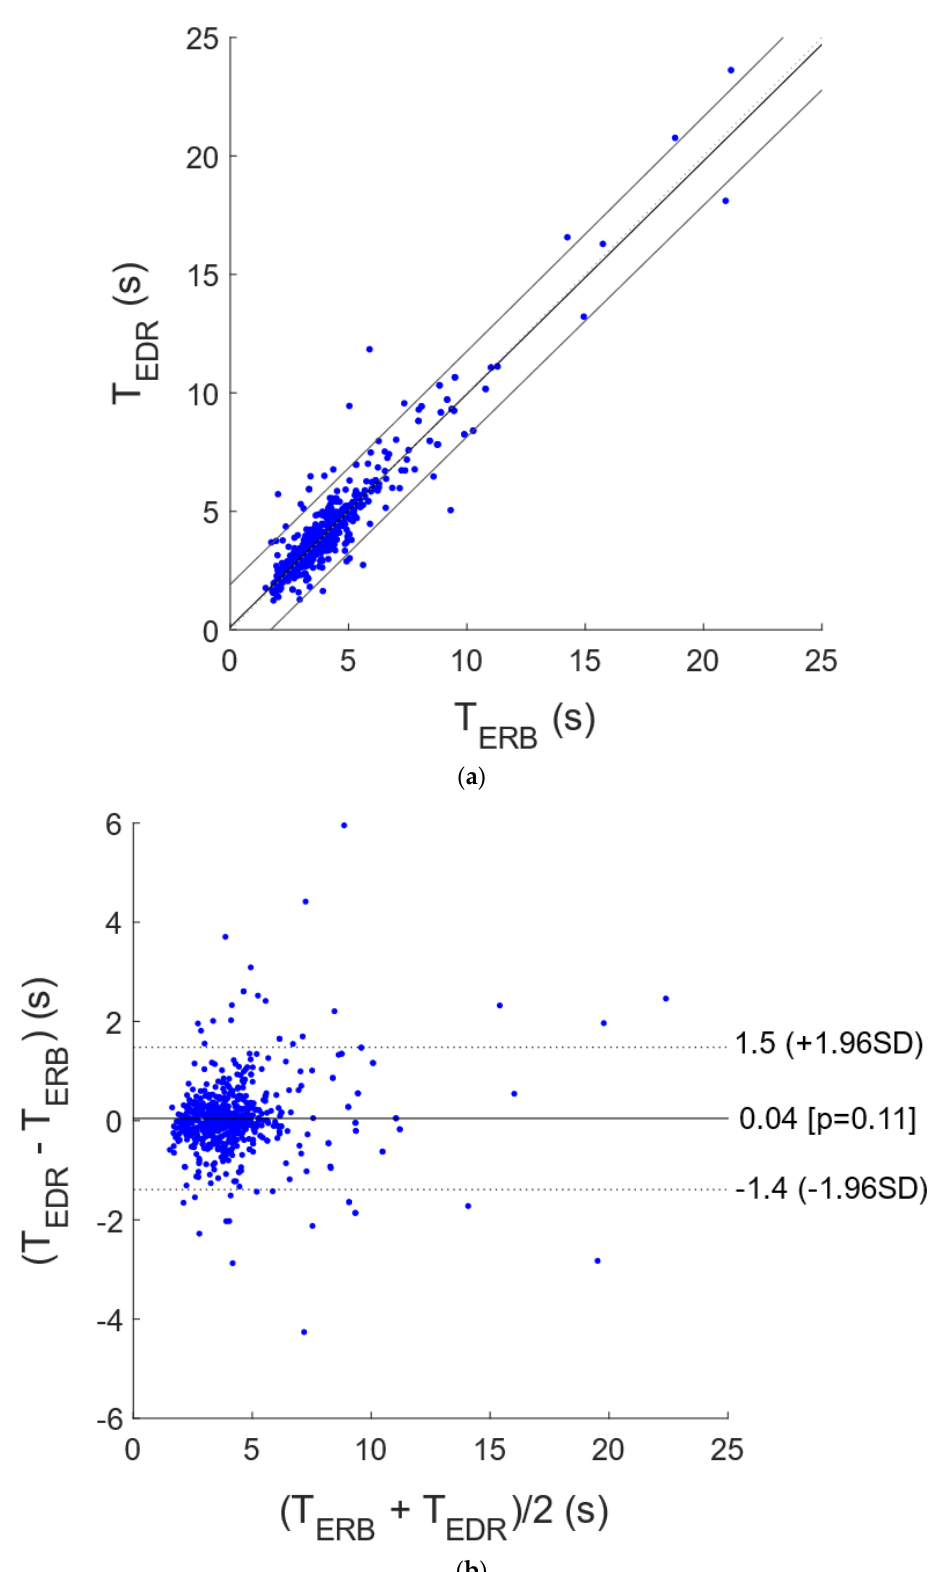
Figure 6. Statistical analyses on inter-respiration intervals estimated from EDR and ERB: ( a ) results of correlation analysis; ( b ) results of Bland–Altman analysis.